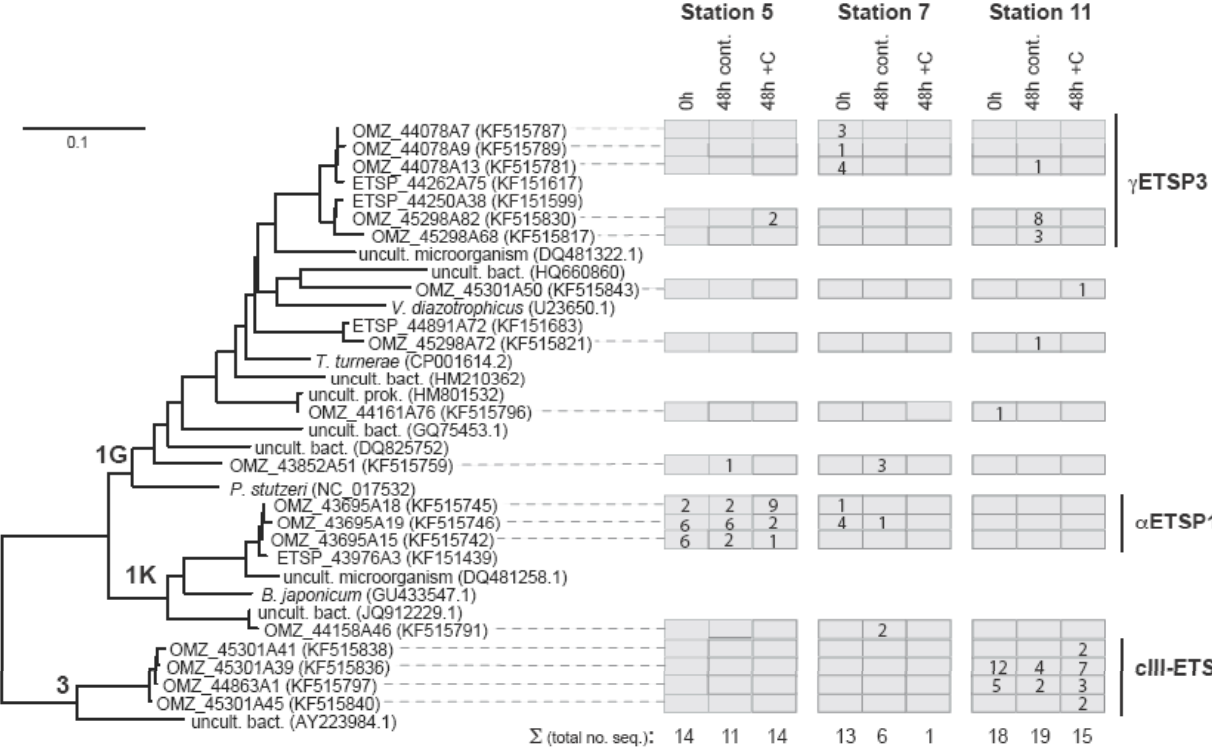
Figure 9. Results from the molecular analyses of the 2010 glucose amendment experiments. Neighbor joining tree of partial nifH nucleotide sequences. Nodes are labeled with nifH cluster designations according to the convention established [74]. The number of sequences recovered from stations and treatments for each phylotype are indicated in boxes to the right of the tree.